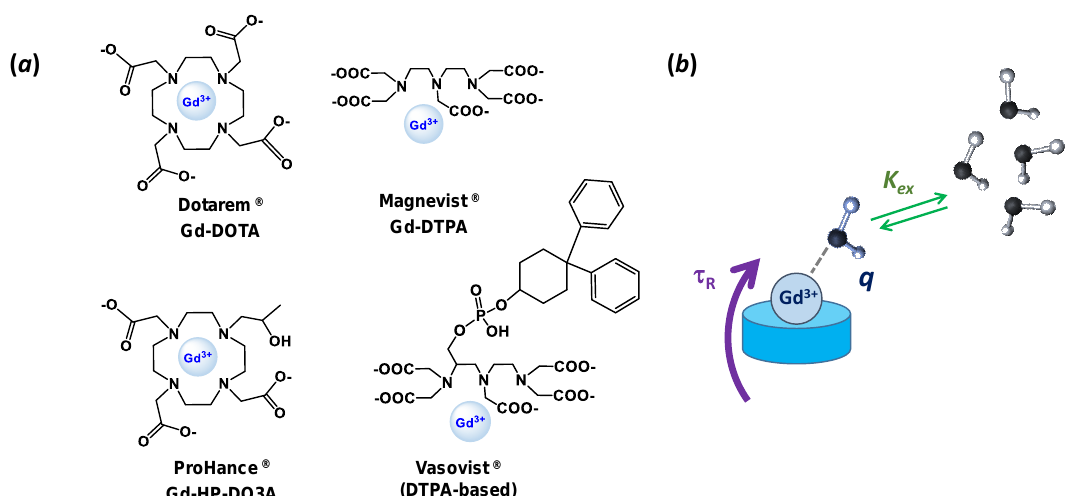
Figure 1. ( a ) Chemical structure of four Gd 3+ complexes in clinical use, Dotarem ® , Magnevist ® , ProHance ® and Vasovist ® ; ( b ) schematic representation of the parameters influencing the relaxivity, that are prone to (chemical) modification: q = number of water molecules directly bound to the Gd 3+ , k ex = water exchange rate and τ R = rotational correlation